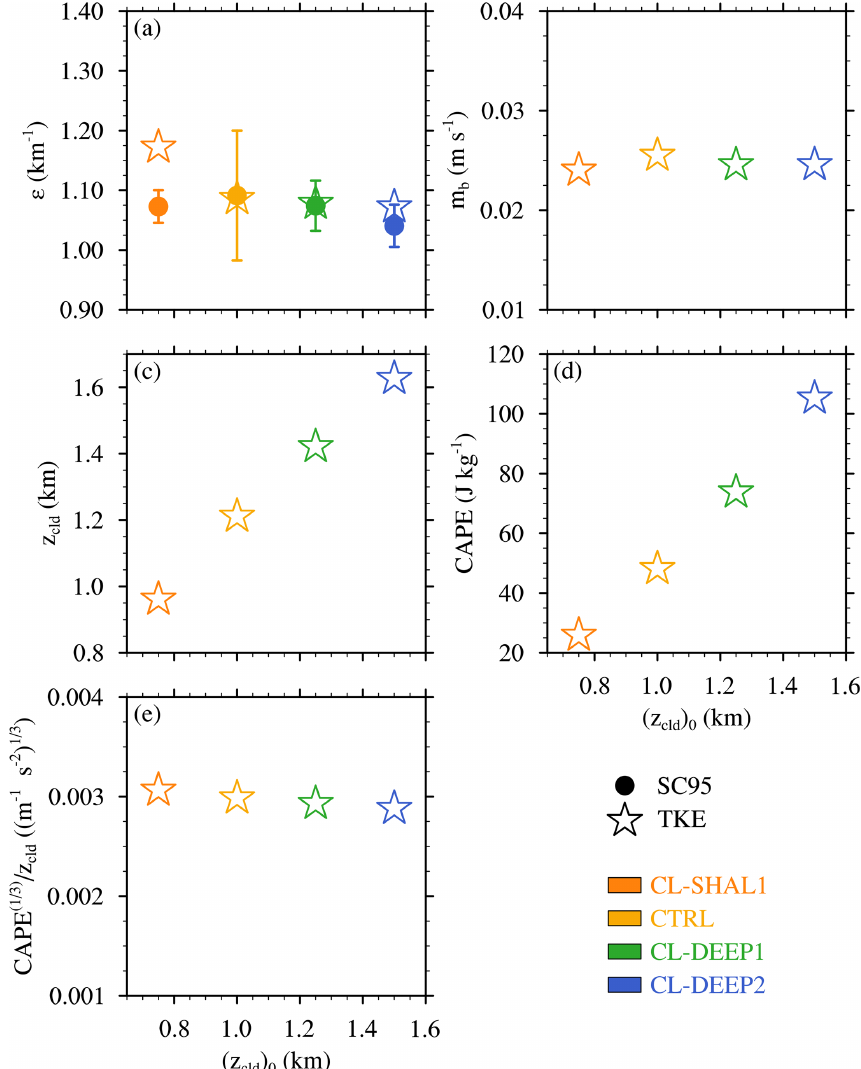
Figure 7. Analysis of experiments with different initial cloud-layer depths ((z cld ) 0 ) : (a) fractional dilution rate ( ε ) calculated using Eq. (1) and estimated using Eq. (8), (b) cloud-base mass flux ( m b ), (c) cloud-layer depth ( z cld ), (d) convective potential available energy (CAPE), and (e) CAPE ( 1 / 3 ) /z cld . The error bars in (a) indicate the width of twice the standard deviation of ε SC95